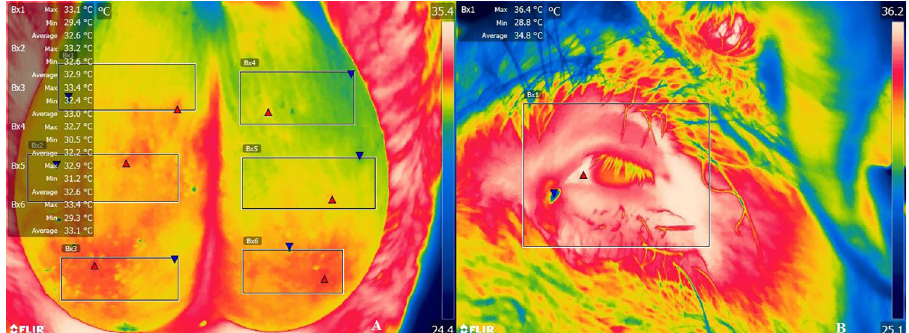
Fig 2. A representative thermal image from the scrotum surface (left and right testicles), with separated areas (A; top, medium, and bottom area), and from the eye (B). Red triangles indicate the highest temperature and the blue triangles indicates lowest temperature of the selected